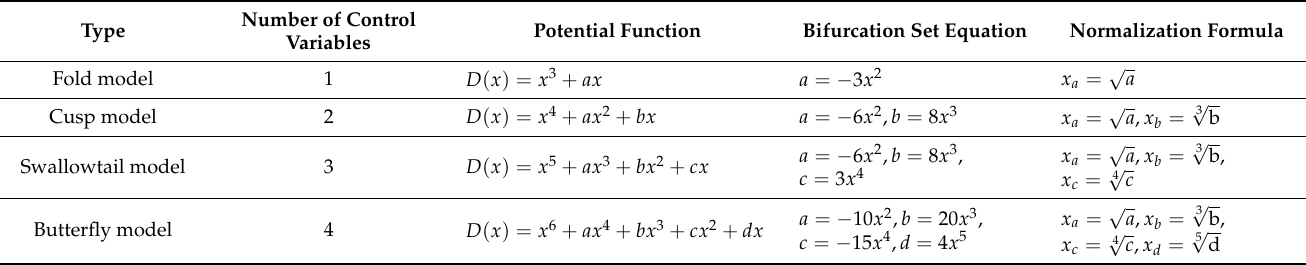
Figure 2. The research framework of land use simulation integrating land ecological security (LES). Table 1. Catastrophe models and normalization